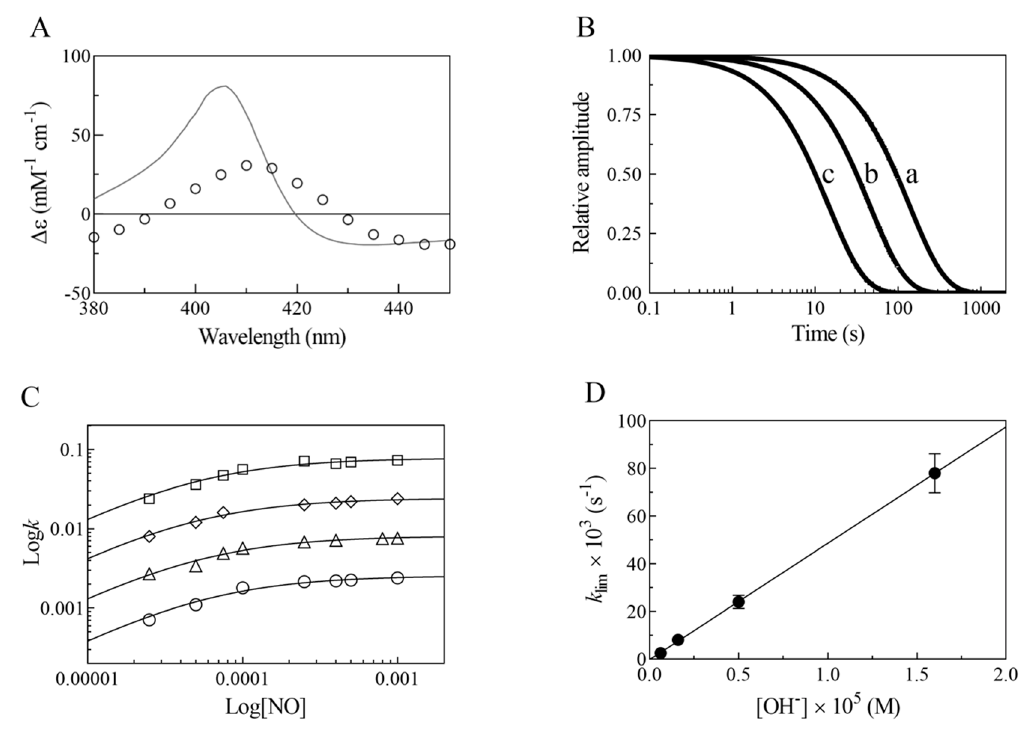
Figure 1. Reductive nitrosylation of Mt -Nb(III) at 20.0 °C. ( A ) Difference optical absorption spectrum of Mt -Nb(III) minus Mt -Nb(II)-NO (static difference optical absorption spectrum; continuous line) and of Mt -Nb(III)-NO minus Mt -Nb(II)-NO (kinetic difference optical absorption spectrum; circles) at pH 7.8. ( B ) Time course of reductive nitrosylation of Mt -Nb(III) at pH 8.2 (a), 8.7 (b), and 9.2 (c). Values of the rate constant k were calculated according to Equation (1): 7.3 × 10 − 3 s − 1 (a), 2.2 × 10 − 2 s − 1 (b), and 6.9 × 10 − 2 s − 1 (c). The Mt -Nb(III) concentration was 4.1 × 10 − 6 M. The